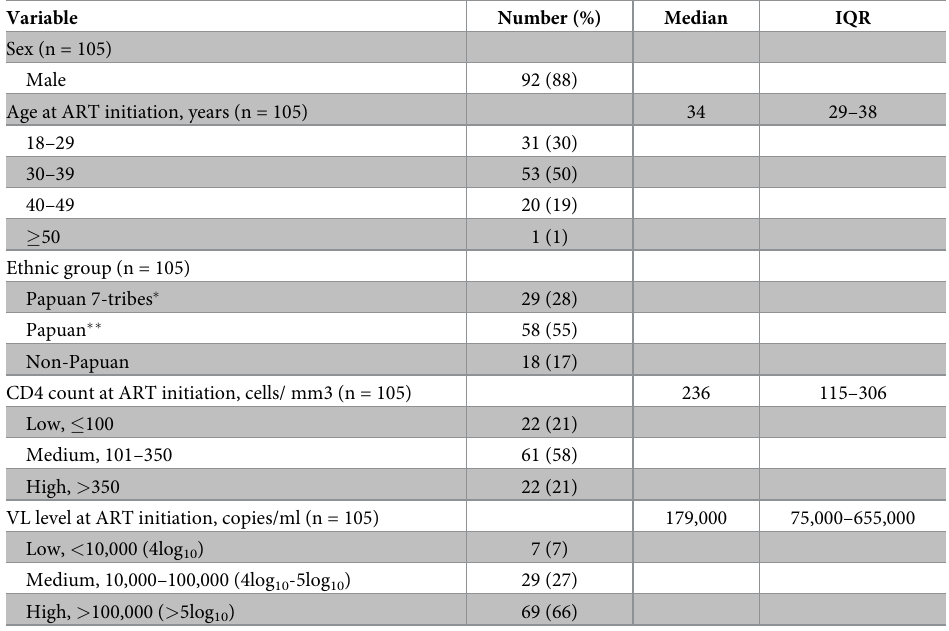
Table 1. Baseline demographic and HIV infection characteristics of study